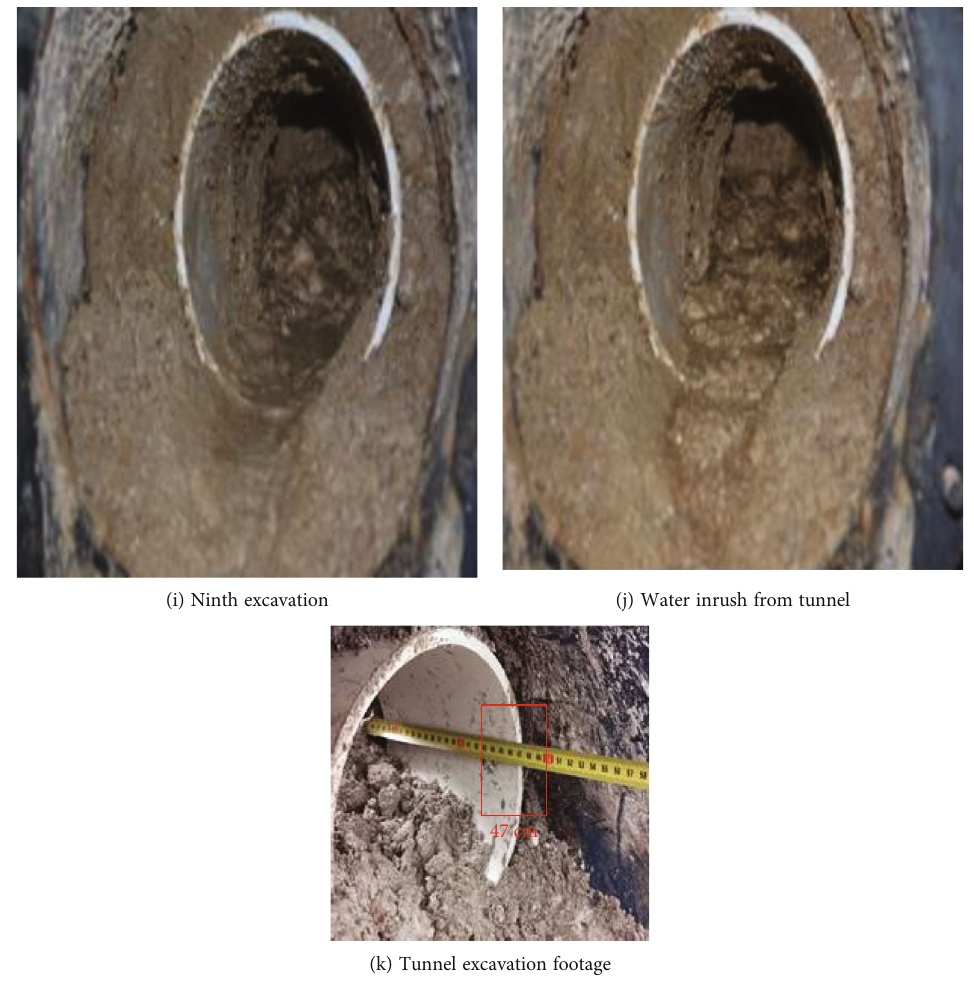
Figure 13: The analysis of stability of the tunnel during